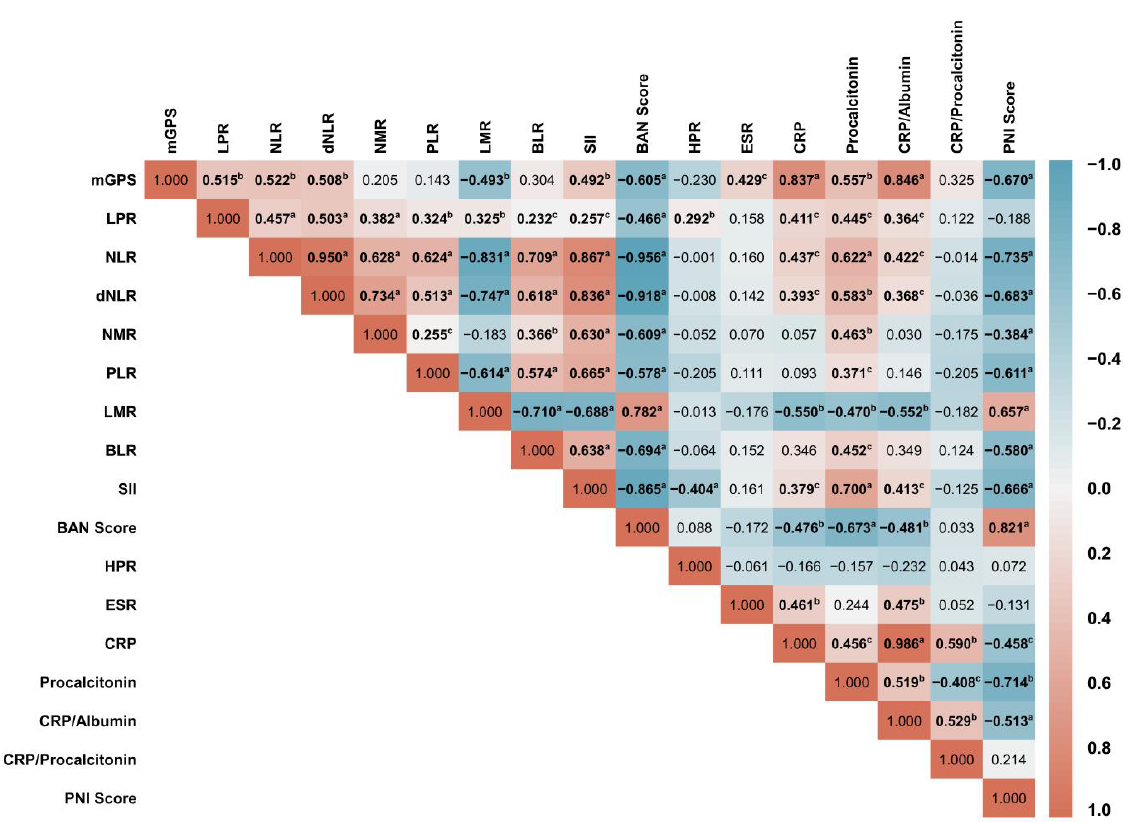
Figure 2. The correlation matrix between inflammatory surrogate marker metrics was depicted as a heatmap, measured using Spearman rank correlation analysis. The heat map represents the colour-coded correlation factors between all markers. The colour value of the cells is proportional to the strength of the associations, ranging from red (positive correlations) to blue (negative correlations). The strength of the correlation is indicated in the colour scale (at the right of the panel), where 1 shows a strong positive correlation, − 1 shows a strong negative correlation, and 0 shows no correlation. Pair-wise-Spearman correlation coefficients ( ρ ) are shown in every cell. A p -value correlation between two inflammatory markers was described as a p < 0.001; b p < 0.01; and c p < 0.05, and others without superscripts were denoted as non-significant ( p >